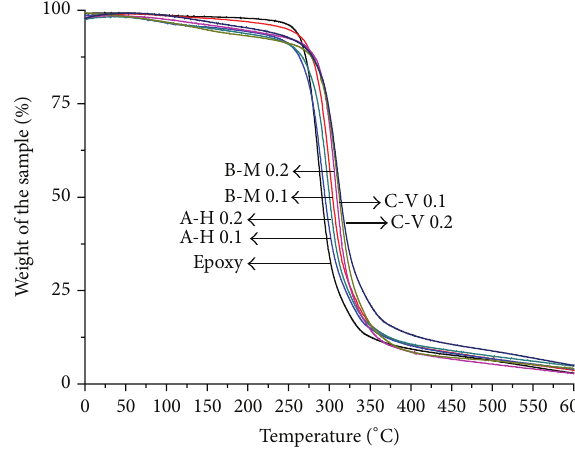
Figure 6: Thermal stability of